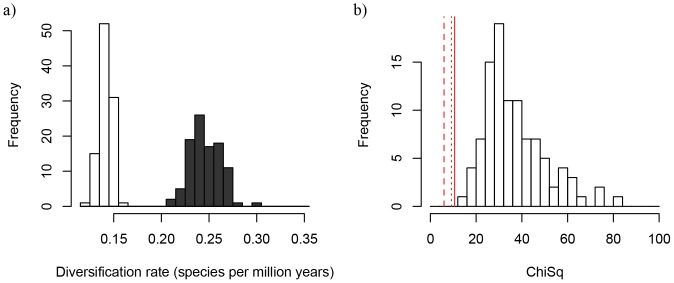
Histograms of BiSSE model inferences based on 100 replicate PACMAD trees.Each tree had 1774 taxa, and the missing diversity was represented as a proportion (sampling frequency). Black bars indicate C4 rates, white bars indicate C3 rates. The panels show: a. Net diversification rates derived from a 6-parameter model, b. Chi Squared values derived from ANOVA comparison of a 6-parameter model and a 4-parameter (equal diversification) model for each tree. The red lines indicate significance values of .05, .01, and .005.